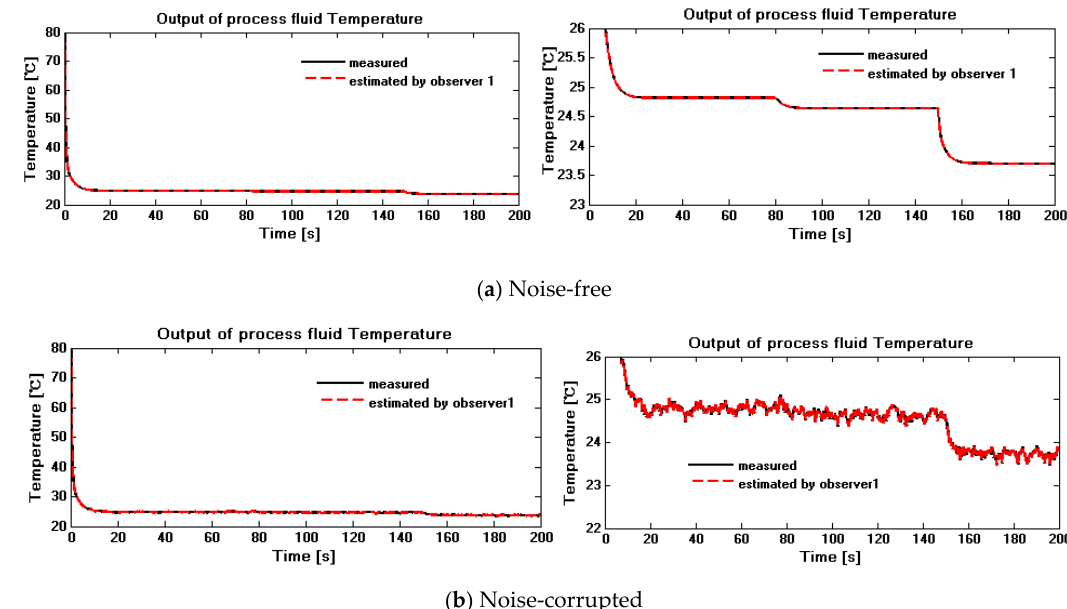
Figure 7. Outlet temperature of the process fluid T p . The solid line is the measured value, and the dashed line is estimated by Observer 1. ( a ) represents Noise-free case while ( b ) represents Noise-corrupted case.